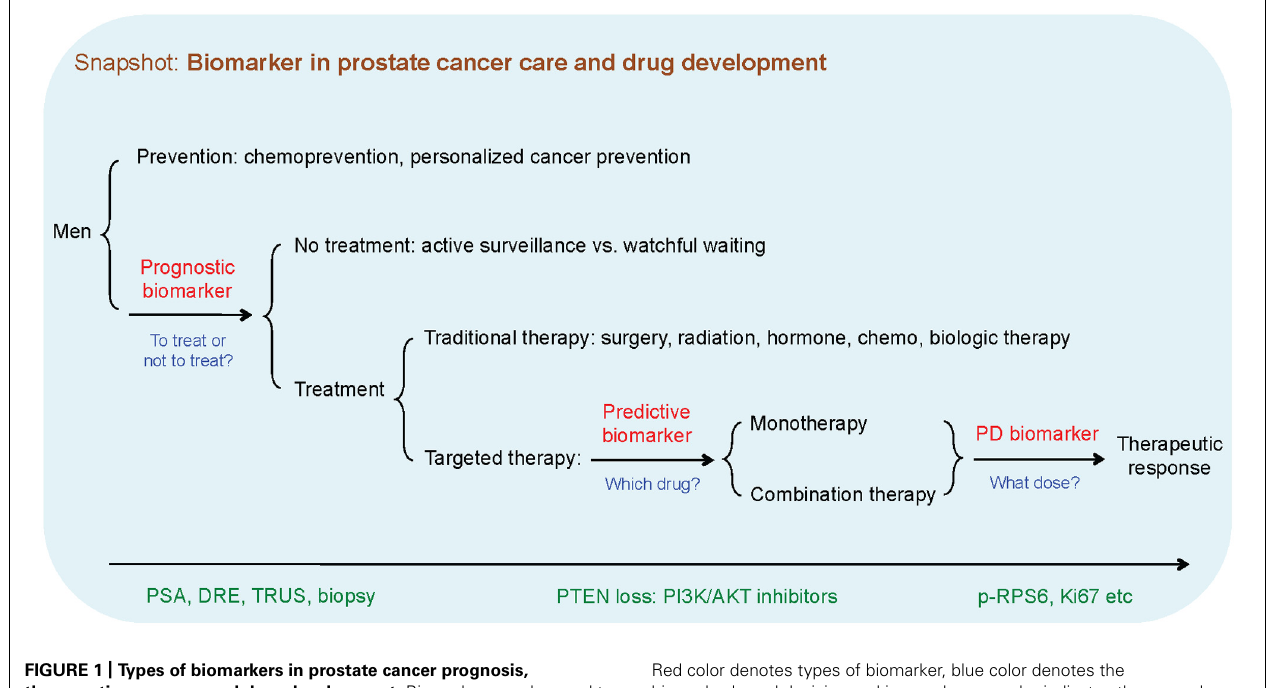
FIGURE 1 | Types of biomarkers in prostate cancer prognosis, therapeutic response, and drug development. Biomarkers can be used to predict the natural course of a prostate disease (prognosis), help clinicians with decision making about the likelihood to respond to a given drug (predictive) and at what dose it might be most effective (pharmacodynamics).